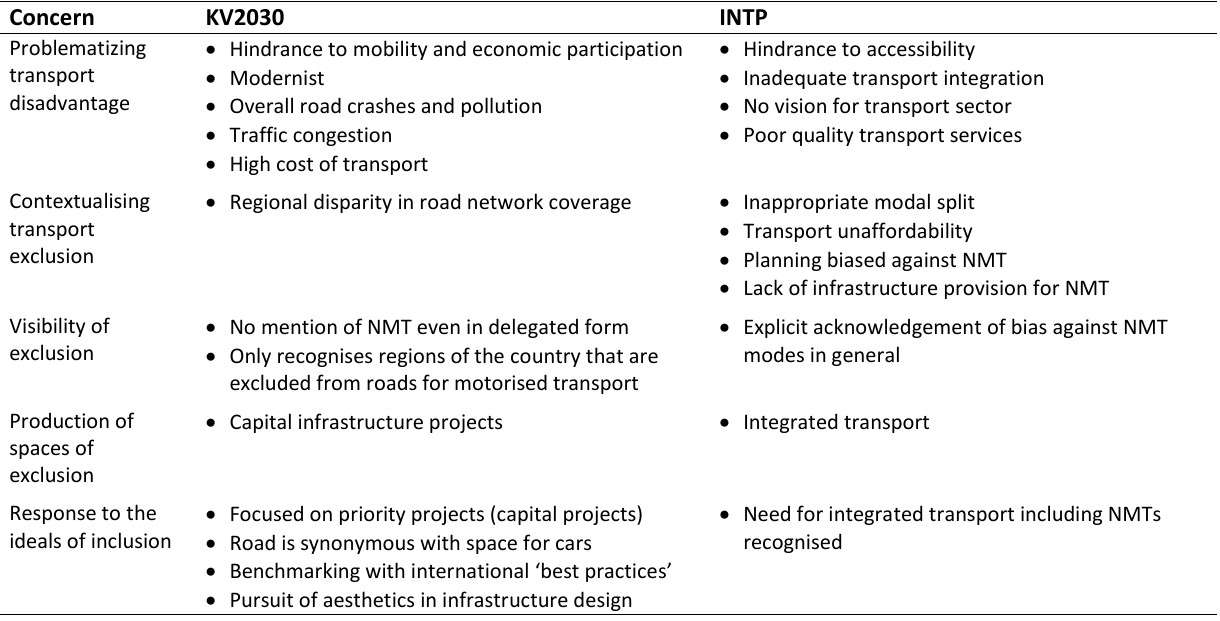
Table 1. The extent to which policy and practice have tackled key thematic concerns of inclusion.